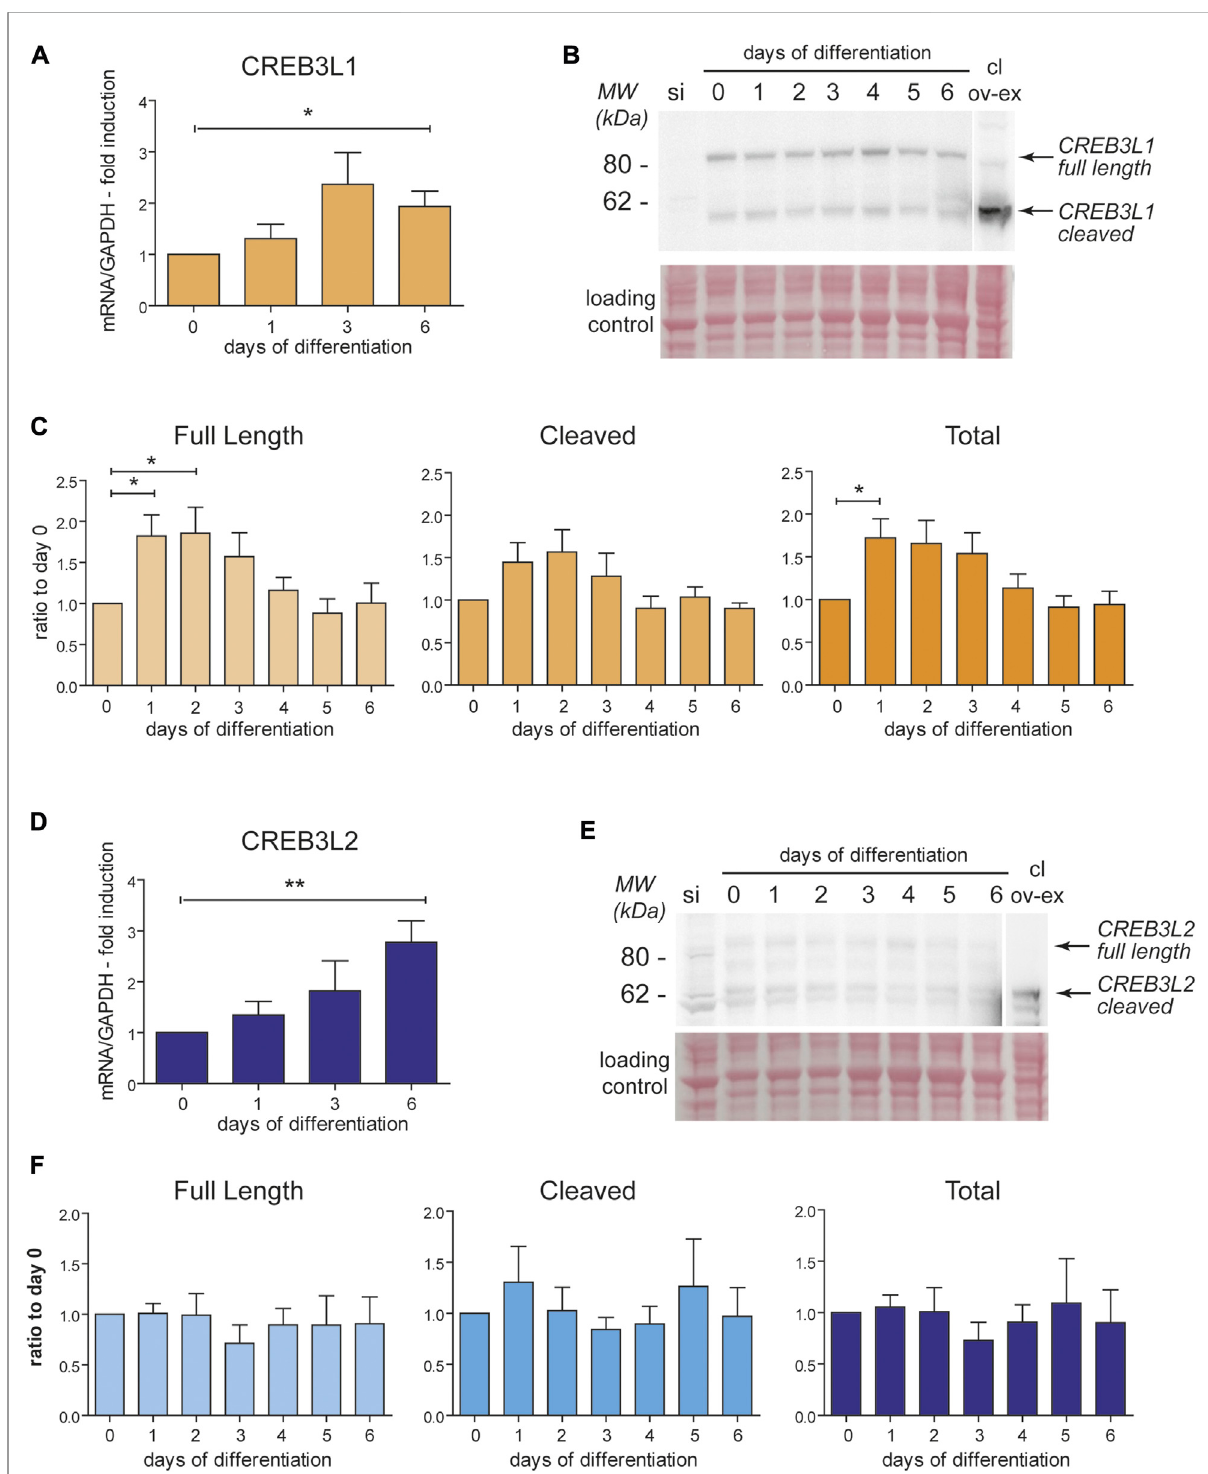
FIGURE 4 CREB3L1 and two are upregulated during decidualization. T-HESC were treated with cAMP and progesterone and samples (RNA and total protein lysates) were collected every day up to day6 after the treatment. (A) mRNA levels of CREB3L1 were quanti fi ed using qPCR, normalized on GAPDH and expressed as fold induction on day 0. The mRNA increases after stimulation up to day 3 and then start decreasing. Average of samples from six independent experiments ± SEM. * p < 0.05, t -test vs day0. (B) 40 µg of total proteins were analyzed in SDS-PAGE, under reducing conditionsona4 – 12%precastedacrylamidegel.Asanegativecontrol,asampleofcellssubjectedtoCREB3L1siRNAthedaybeforewereloaded(si).